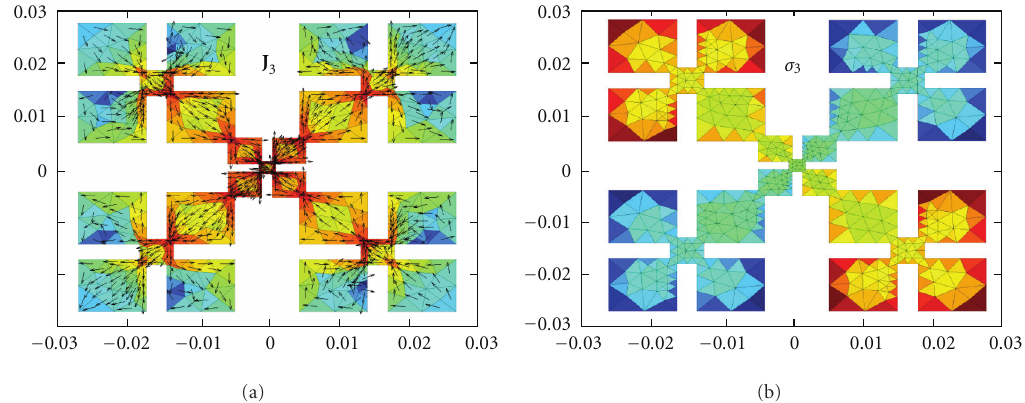
Figure 14: Second higher mode J 3 (currents and charges).